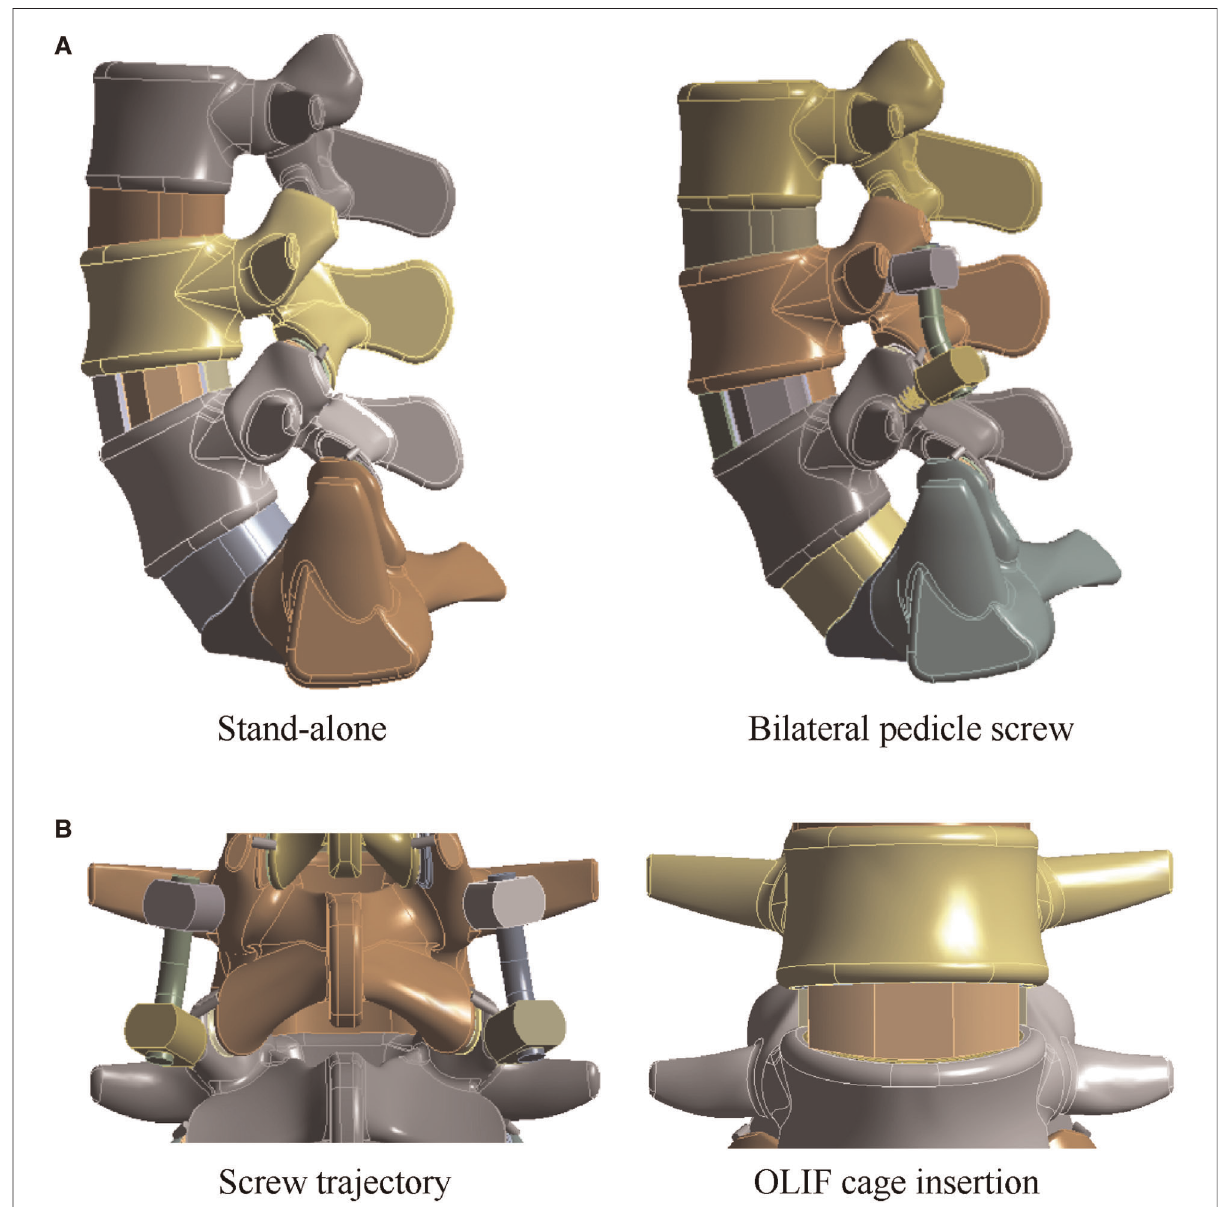
FIGURE 1 Schematic for surgical simulations in the lumbo-sacral model. ( A ) The intact lumbo-sacral model; ( B ) Simulations for S-A OLIF and OLIF fifi xed by